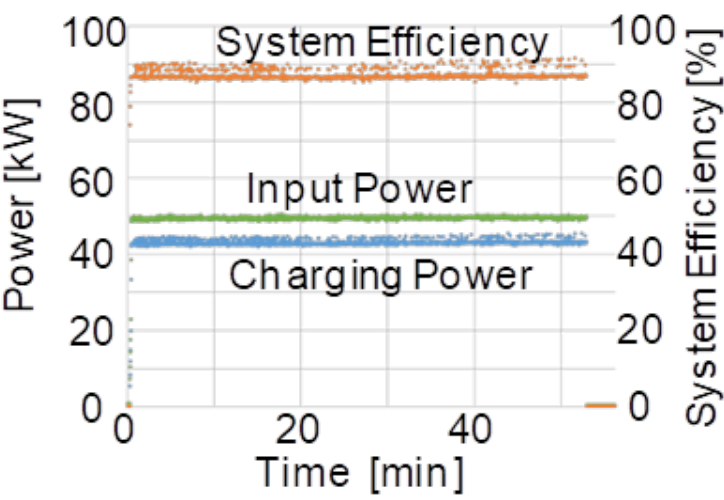
World Electric Vehicle Journal 2019 , 10 , x FOR PEER REVIEW Figure 7. The medium-size bus and the receiving equipment installed on the bus.